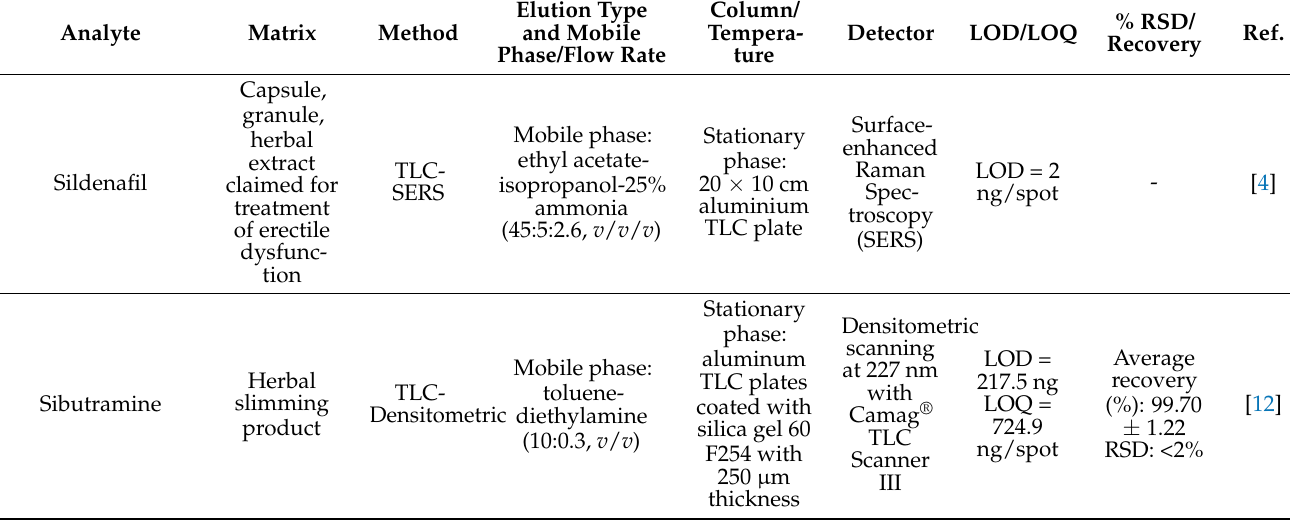
Table 1. Various chromatographic methods for determining adulterated drugs in herbal medicine.